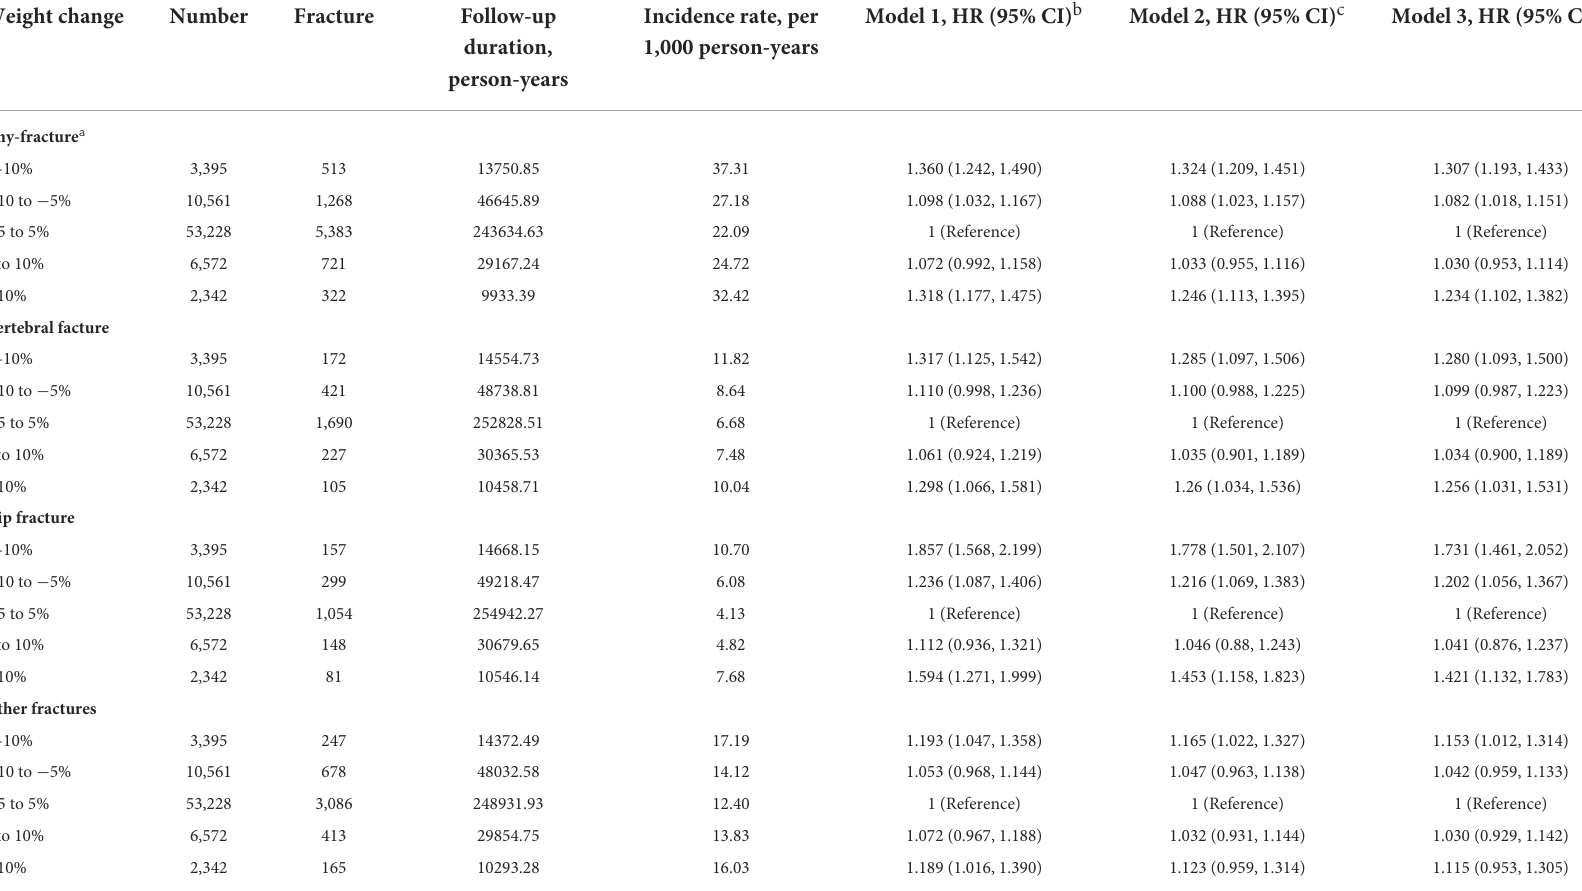
TABLE 3 Sensitivity analysis of incidence rates and hazard ratios of fractures according to the status of weight changes after excluding fractures within 1 year of